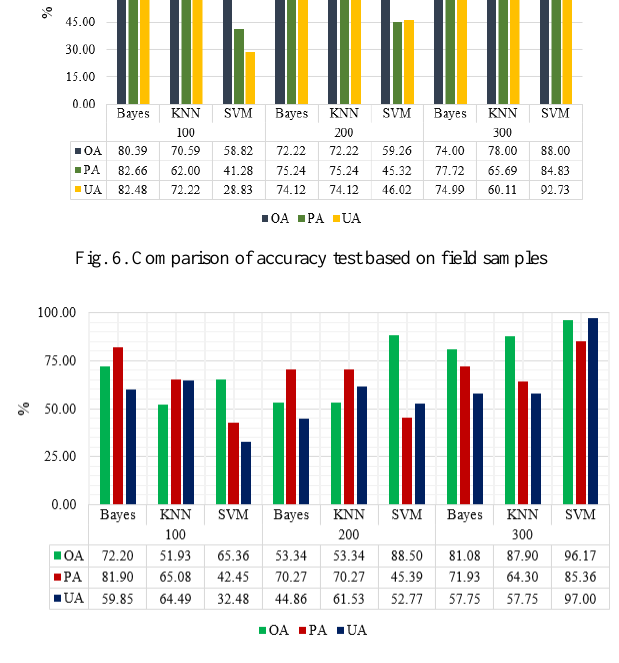
Fig. 8. Classification using SVM algorithm a scale parameter of 300